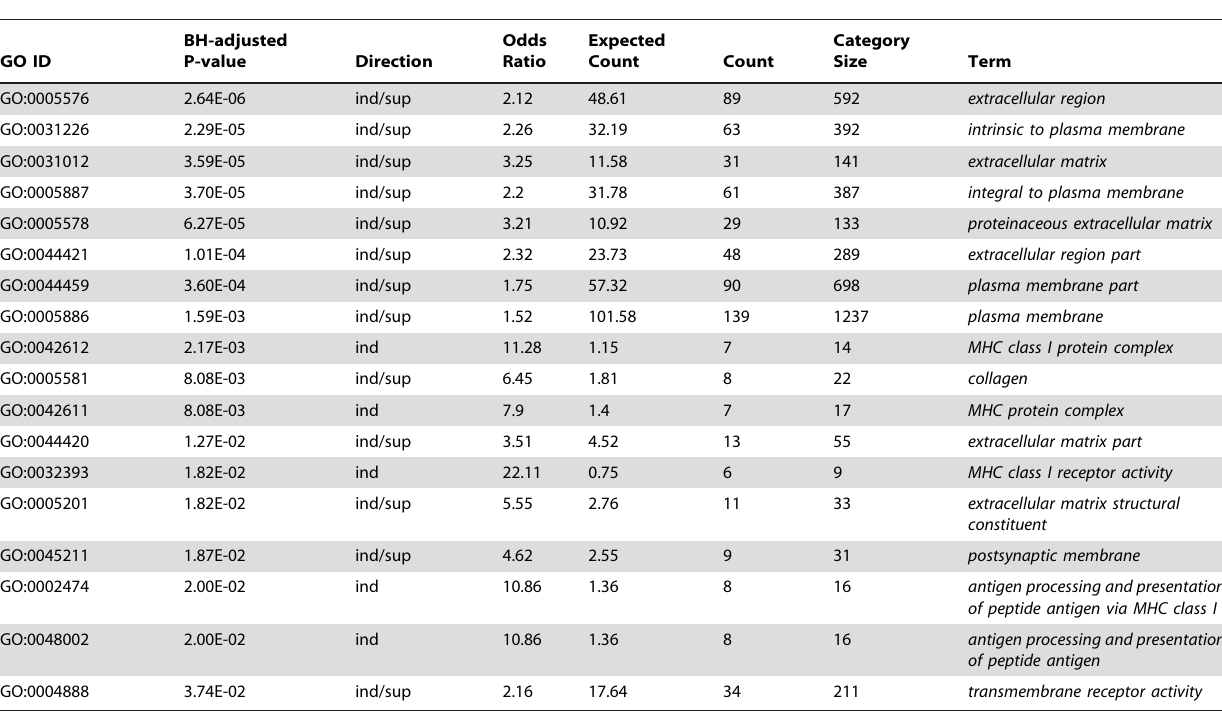
Table 1. GO terms enriched in the set of differentially expressed